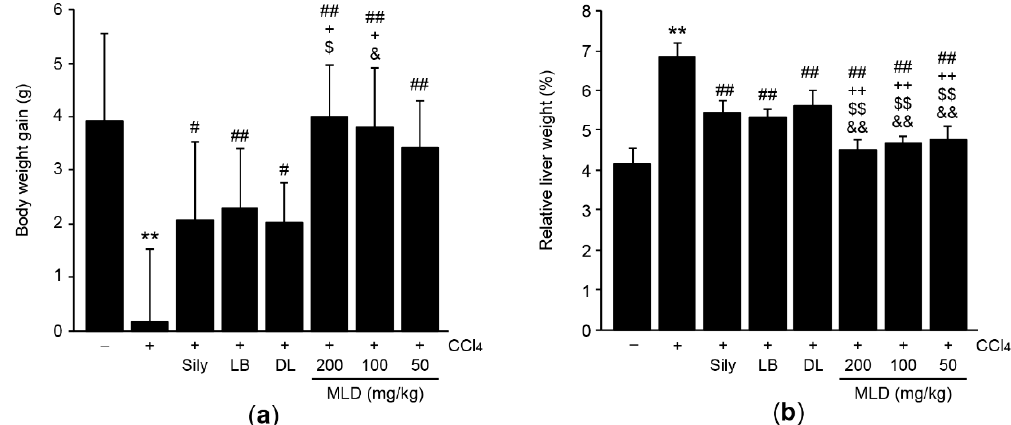
Figure 1. Effects of mixture of lemon balm and dandelion extracts (MLD) on body weight gain and relative liver weight in CCl 4 -treated mice. Mice were treated with silymarin (Sily), lemon balm leaf extract (LB), dandelion leaf extract (DL) or one of three doses of MLD once daily for 7 days. On day 6, CCl 4 was injected at 1 h after the final administration of herbal drugs. Body weight gain ( a ) and relative liver weight ( b ) were measured. All values are expressed as mean ± SD of ten mice. ** p < 0.01 between the vehicle and CCl 4 groups; ## p < 0.01, # p < 0.05 versus CCl 4 -injected mice; ++ p < 0.01, + p < 0.05 between Sily- and MLD-treated mice; $$ p < 0.01, $ p < 0.05 between LB- and MLD-treated mice; && p < 0.01, & p < 0.05 between DL- and MLD-treated mice.